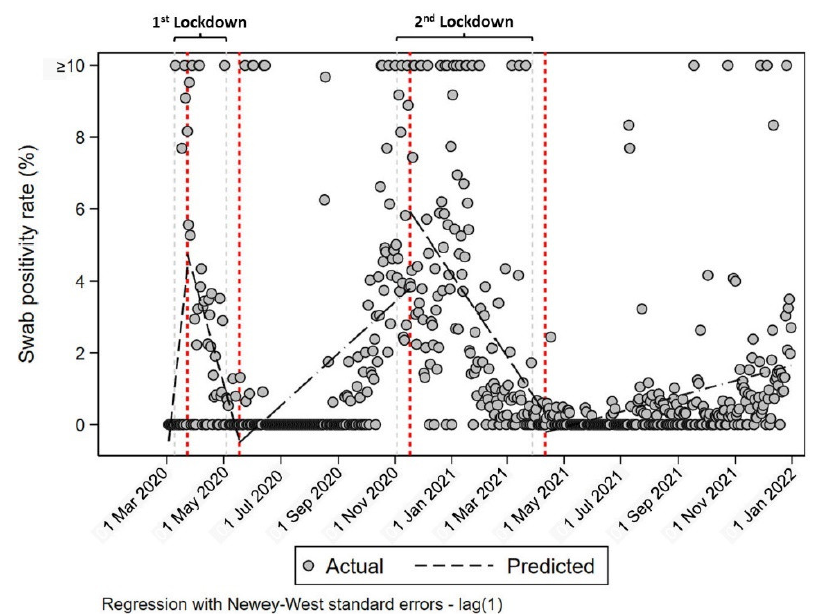
Figure 3. Daily swab positivity rate reported over time showing the intervention points. Red dotted lines represent the start and the end of each lockdown + 14 day